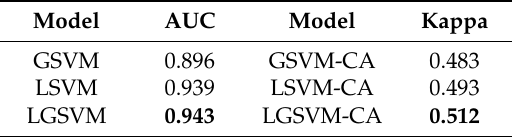
Table 5. The AUC and kappa values of the probability maps and CA models for the period of 1996–2002. Model AUC